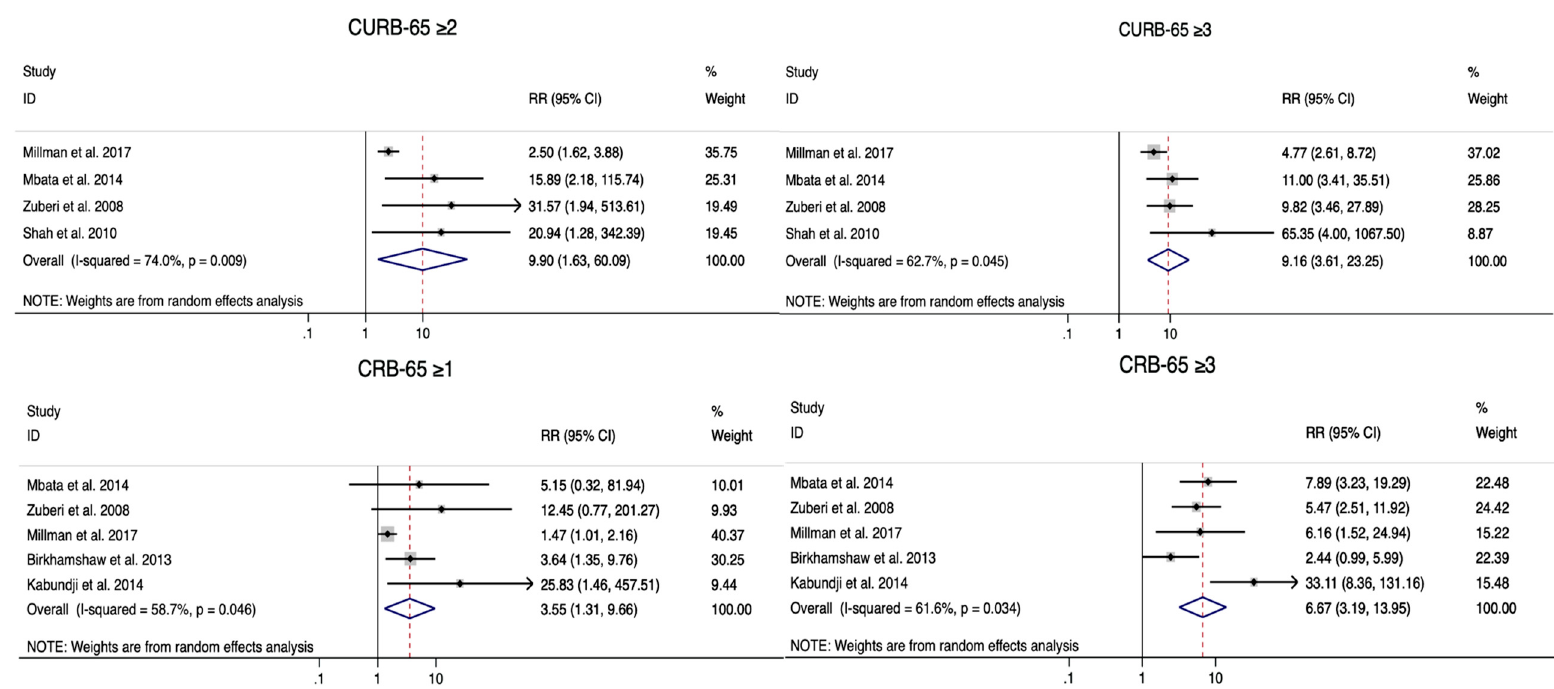
Figure 2. Forest plots of the association between CURB-65 and CRB-65 at the studied cut-offs and mortality prediction in patients with community-acquired pneumonia.